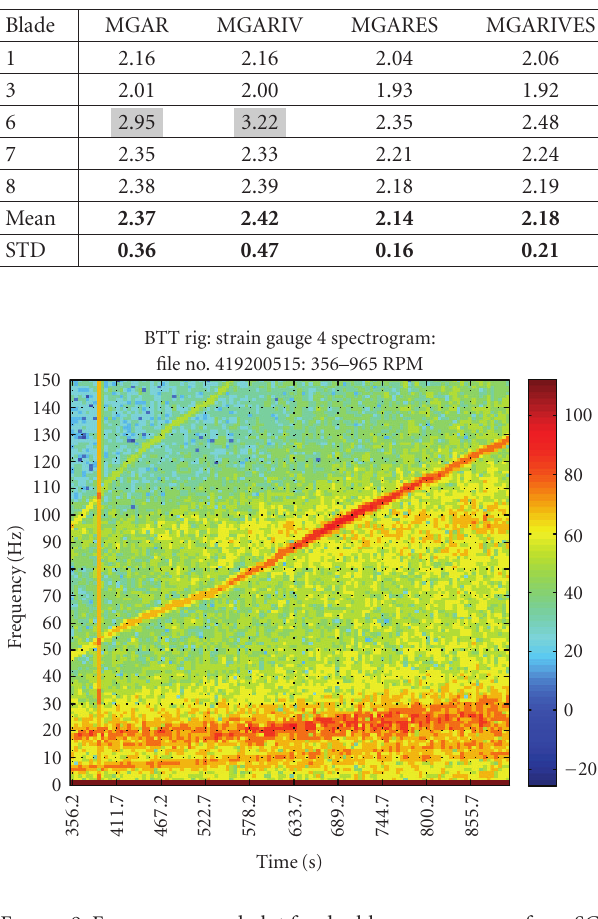
Figure 9: Frequency-speed plot for double resonance case from SG data.